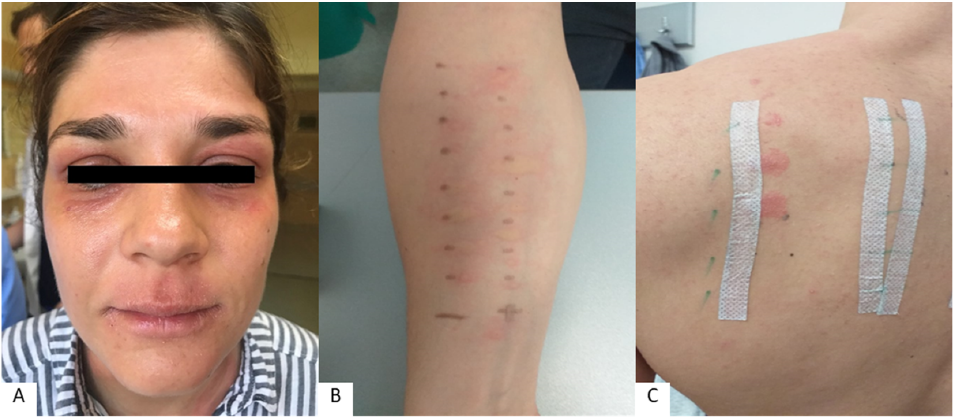
Figure 5. Cheilitis and periorificial lesions in patient with confirmed allergies (atopic dermatitis) ( A ), positive prick test to inhalant allergens ( B ), and positive patch test to contact allergens ( C ). A patch test for contact allergens, performed with standard contact allergens, is es- sential in the assessment of contact cheilitis; however, possible allergens to personal prod-